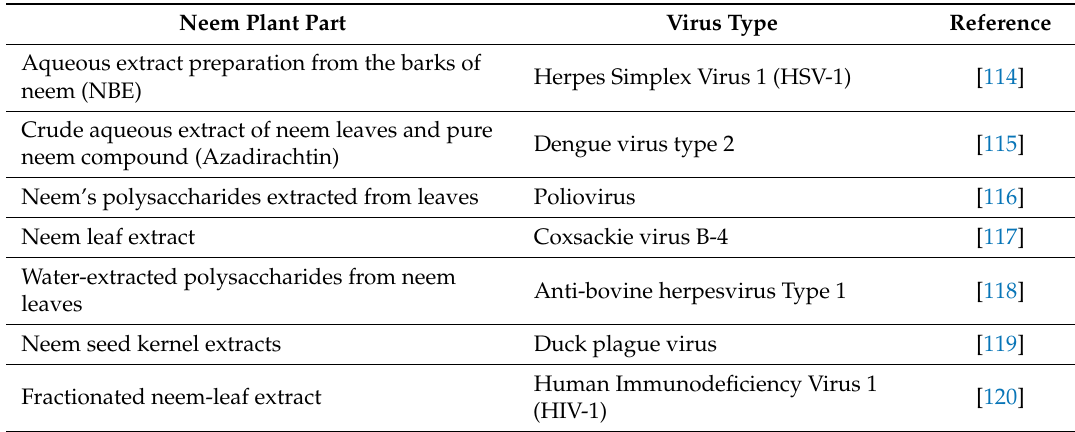
Table 2. Antiviral properties of